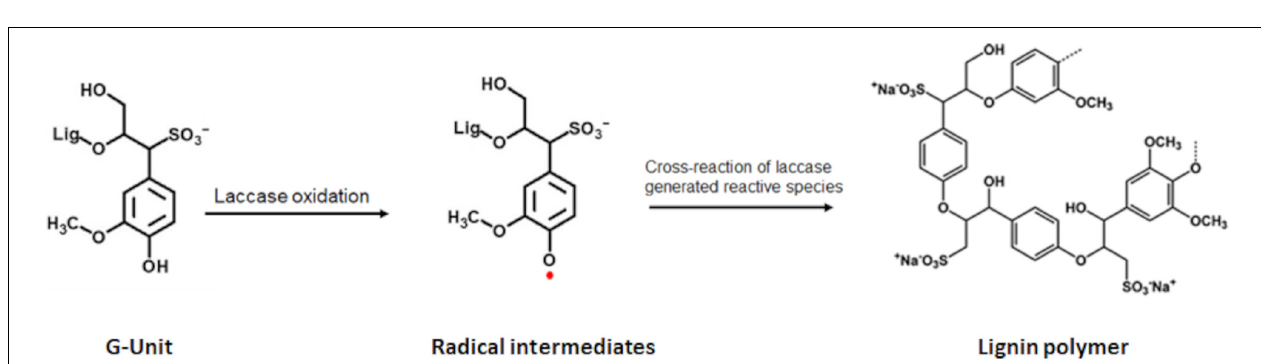
FIGURE 1 | Structures of the relevant reactive molecules. Shown are the monolignol units G (A) and S (B) of lignin (the H unit is not shown due to its low abundance in wood biomass). Further, the Fluorophenol molecule, 4-[4-(trifluoromethyl)phenoxy]phenol (4,4-F3MPP), used for the reaction is shown (C) .